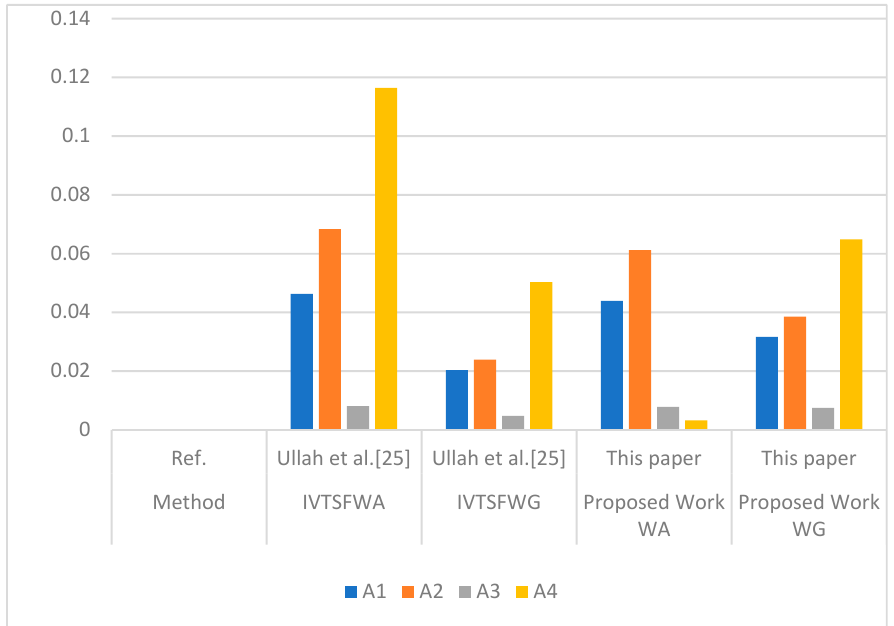
Figure 4. Interpretation of the information in Table 6.